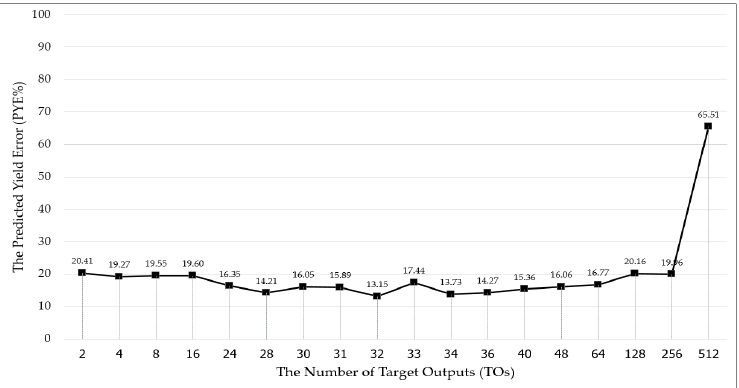
Figure 12. All PYE%s resulting from the TO design process.